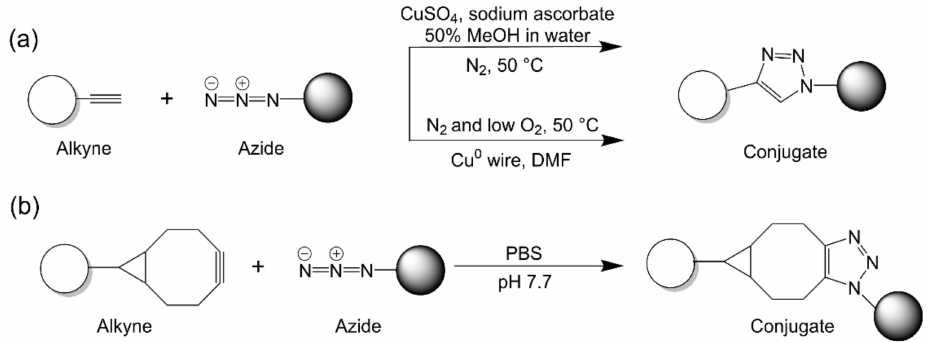
Figure 4. “Click” chemistry. ( a ) Copper-catalyzed azide–alkyne cycloaddition. ( b ) Strain-promoted azide–alkyne